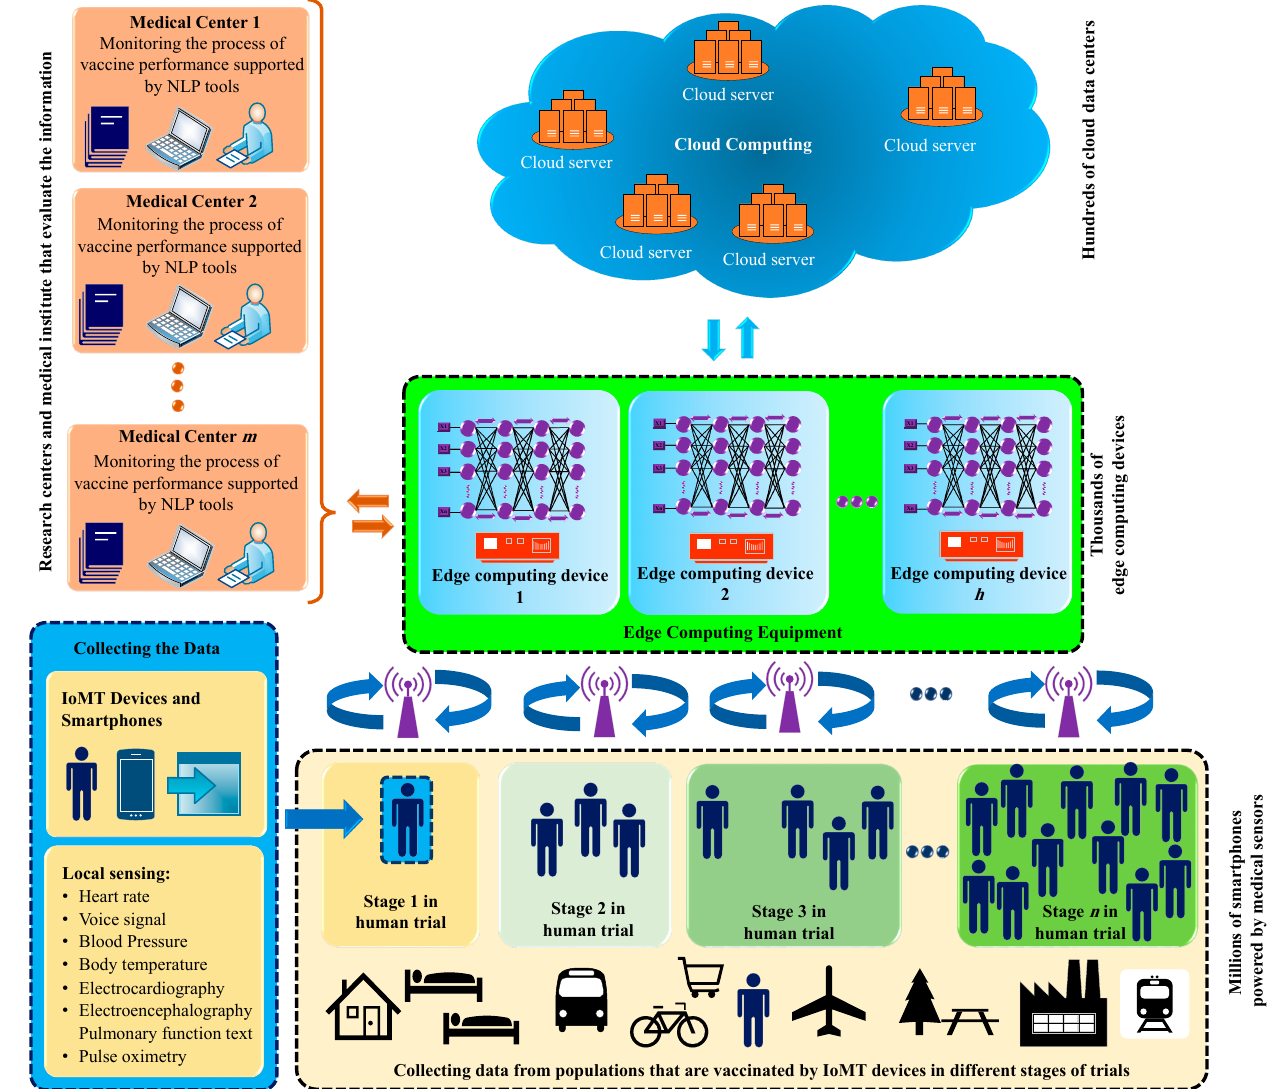
Figure 2. Layer Six: Architecture for Vaccinated Persons’ Health-Data Monitoring and Control. The proposed architecture for Layer 6 in a framework for monitoring and controlling vaccinated persons’ health data is composed of three main sections. Firstly, a number of sensors and IoMT devices are used to collect health data from individuals. Secondly, an EC (edge computing) platform processes the collected data at maximum speed, and a network of physicians, researchers, and natural language processing (NLP) tools supervise the process. Thirdly, CC (cloud computing) servers support the EC-platform infrastructure but do not directly participate in processing the health data [29]. This framework provides real-time monitoring and analysis of health data, which can be used to identify potential health concerns or track the effectiveness of vaccination programs. The use of sensors, IoMT devices, and NLP tools ensures that the framework operates efficiently and